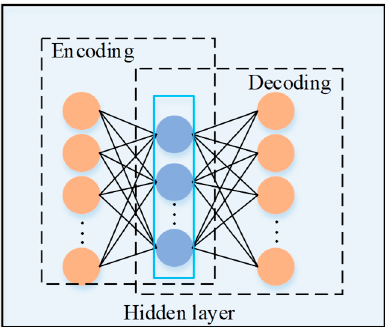
Figure 1. Schematic of AE.